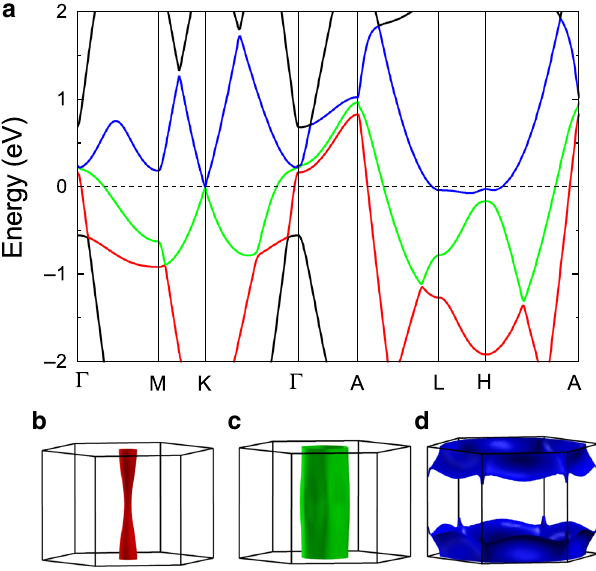
Fig. 4 Calculated band structure and FS topology of BaGa 2 . a Band structure of BaGa 2 along high-symmetry paths of the Brillouin zone calculated with SOC. b and c Two hole-type Fermi surfaces and d one electron-type Fermi